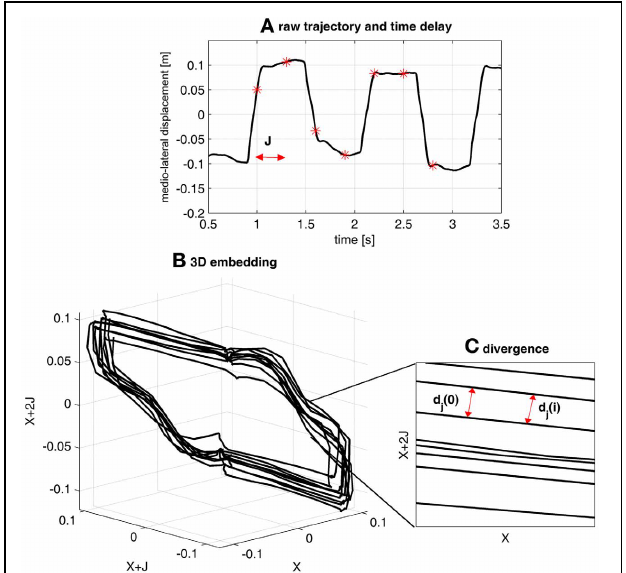
FIGURE A1 | Illustration of the computing of LDS with gait data. (A) Shows 3.5s of the medio-lateral displacement of the center of pressure sampled at 50Hz. The result of the average mutual information analysis was 18 samples (0.36s), which defined the reconstruction delay J. The results of the false neighbor analysis revealed that the minimal embedding dimension should be 6. Therefore, five time-delayed copies of the original time series have been built, according to the Equation 2. (B) Displays the reconstructed attractor with J = 18 and m = 6. Only the first three dimensions are used to build a 3D projection of the 6D attractor. (C) Is a 2D magnification of the attractor. It shows the flow of the trajectories along which the maximal Lyapunov exponent will be computed. Two nearest neighbors (Equation A3) are shown, separated by the initial distance d j (0). Two downstream points are separated by the distance d j (i) (Equation A4).